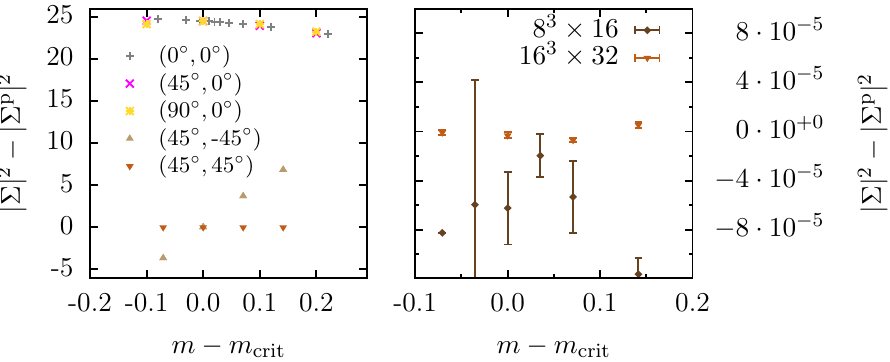
Figure 15 . Difference of the absolute values squared of the chiral condensate Σ and the parity con- densate Σ p . For ϕ = 0 ◦ the chiral condensate dominates this value while for ϕ = 45 ◦ the contribu- tions of the chiral condensate and the parity condensate are approximately the same. Left: different twist angles ( α, ϕ ) on the 16 3 × 32 lattice. Right: different lattice sizes for α = ϕ = 45 ◦